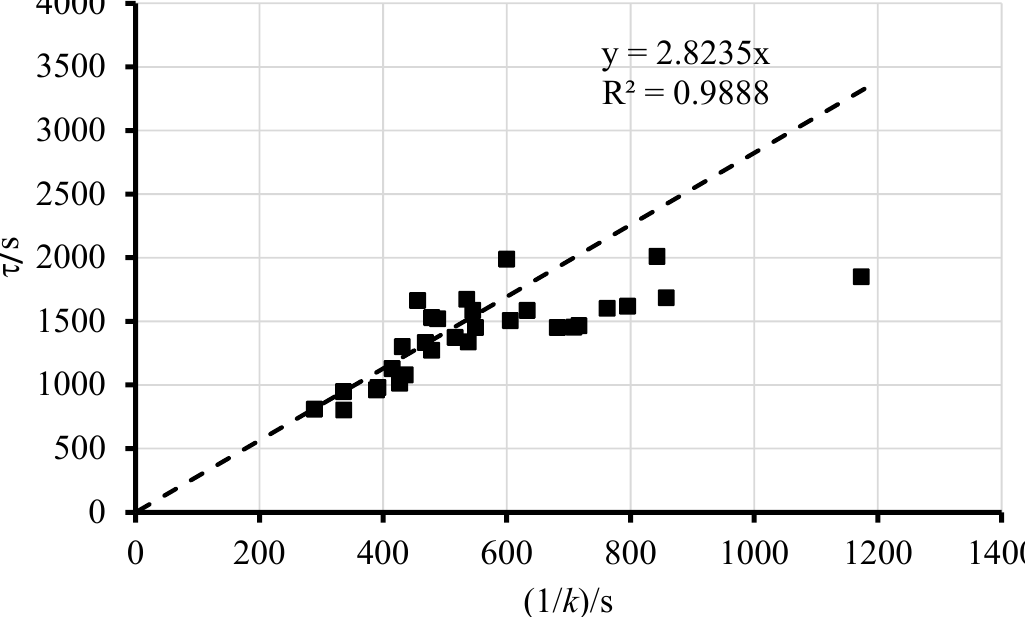
Figure 10. Plot showing a comparison of the mass transfer parameters obtained from the adsorption calorimetry and adsorption-corrected mass uptake methods at different carbon dioxide saturations for adsorption isotherms on the Above Marine Band Bowland shale. The dashed line shown is a fit of the data to a straight-line function through the origin.